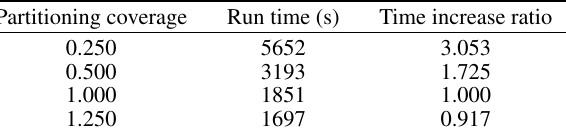
Table 5 Impact of partitioning coverage on synthetic